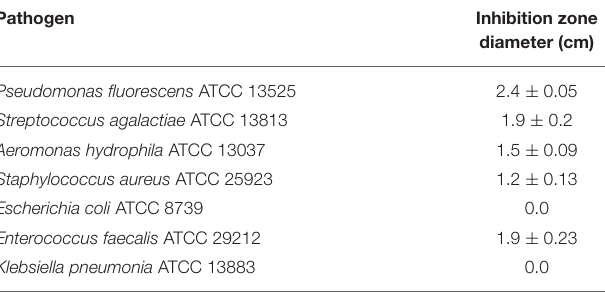
TABLE 2 | Antimicrobial activity of L. plantarum EI6 cell-free supernatant against indicator pathogens. Pathogen